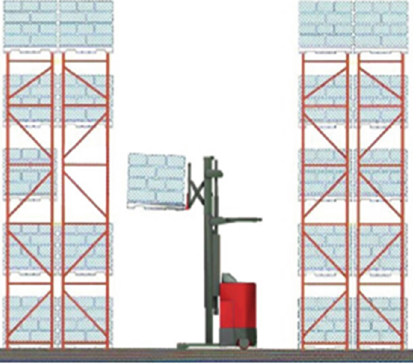
Figure 1: Configuration of a double-deep rack.